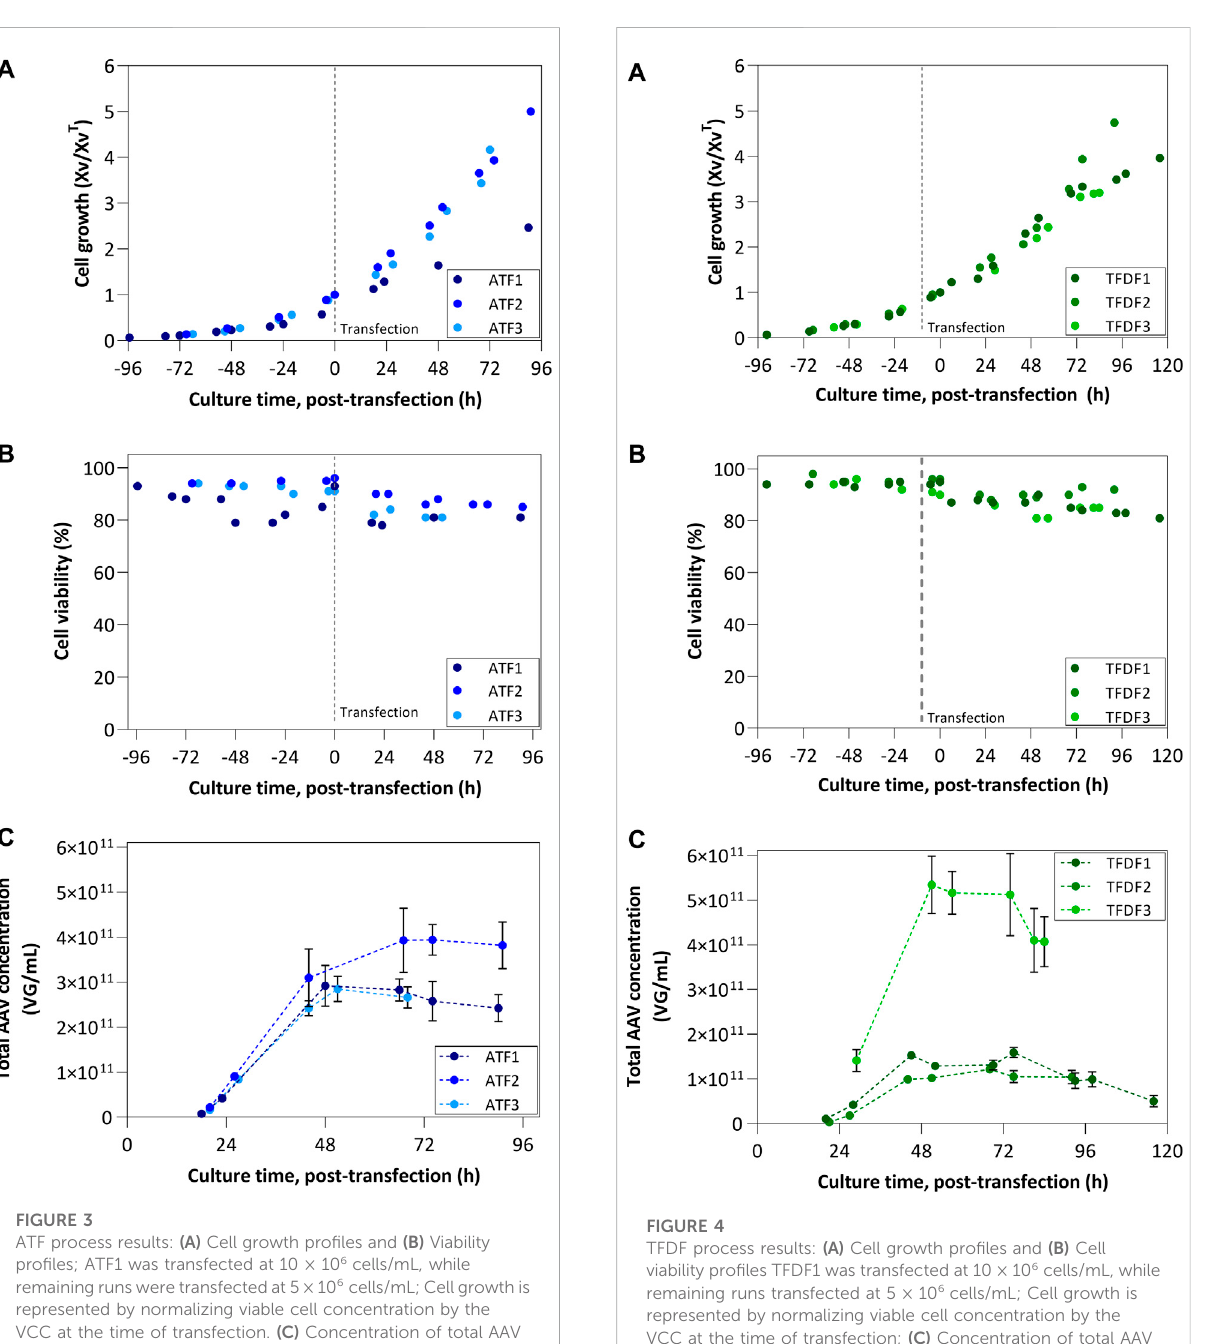
from 1 – 3 NTU. Knowing that the pore size of TFDF fi lters (2 – 5 µm) is substantially different from that of ATF fi lters (0.2 and 0.5 µm), a follow-up experiment was run in which secondary fi ltration was evaluated after TFDF using fi lters with a lower pore cutoff (similar to batch clari fi cation scheme) for a fair comparison between TFDF and ATF. The results are summarized